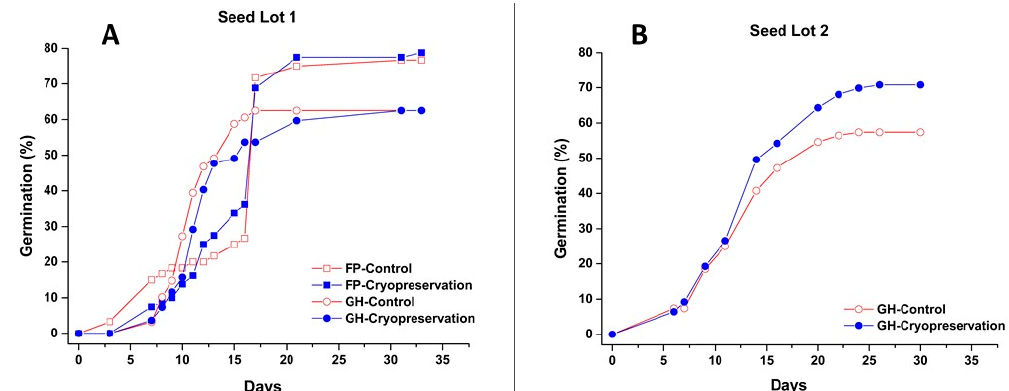
Figure 3. Germination percentage over 35 days under in vitro and greenhouse conditions for control and cryopreserved seeds of two different seed lots, seed lot 1 ( A ) and seed lot 2 ( B ) of Lupinus rivularis . FP—in vitro seed germination was performed on filter paper using 9 cm Petri dishes in the growth chamber; GH—seed germination was performed on soil substrate in the greenhouse.